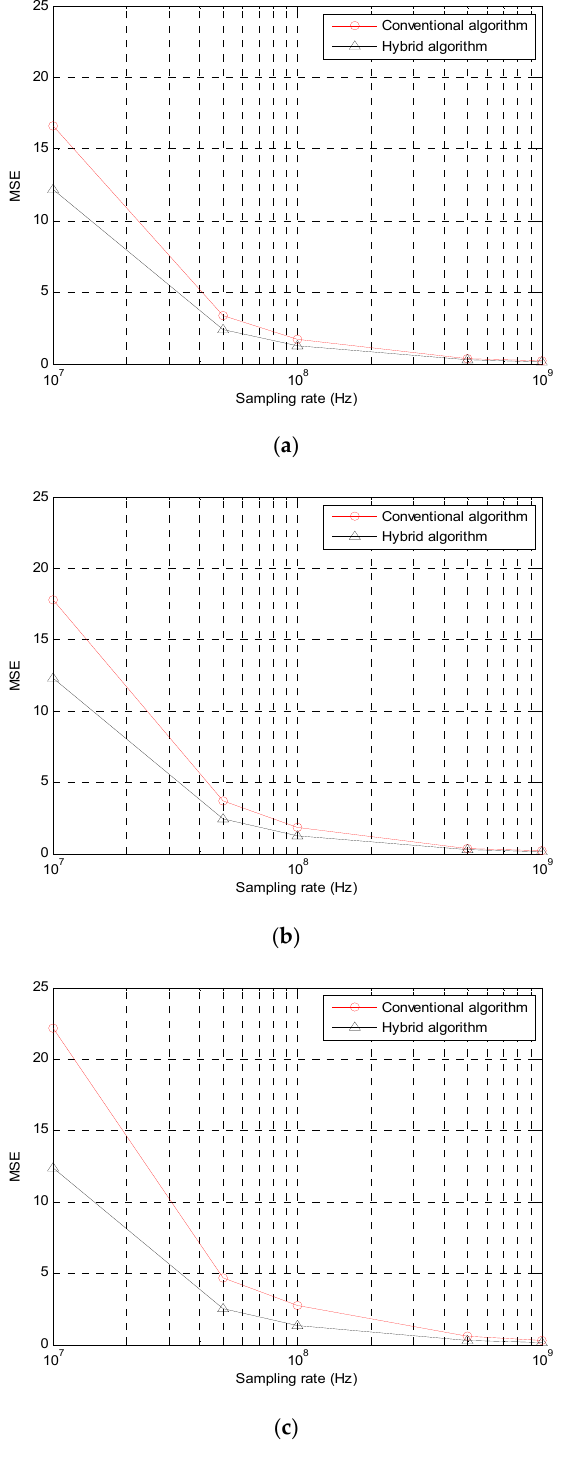
Figure 10. MSE curves for the estimated MS locations based on the proposed hybrid algorithm and the conventional algorithm, of the second scenario for ( a ) the first case, ( b ) the second case, and ( c ) the third case, for the first set.